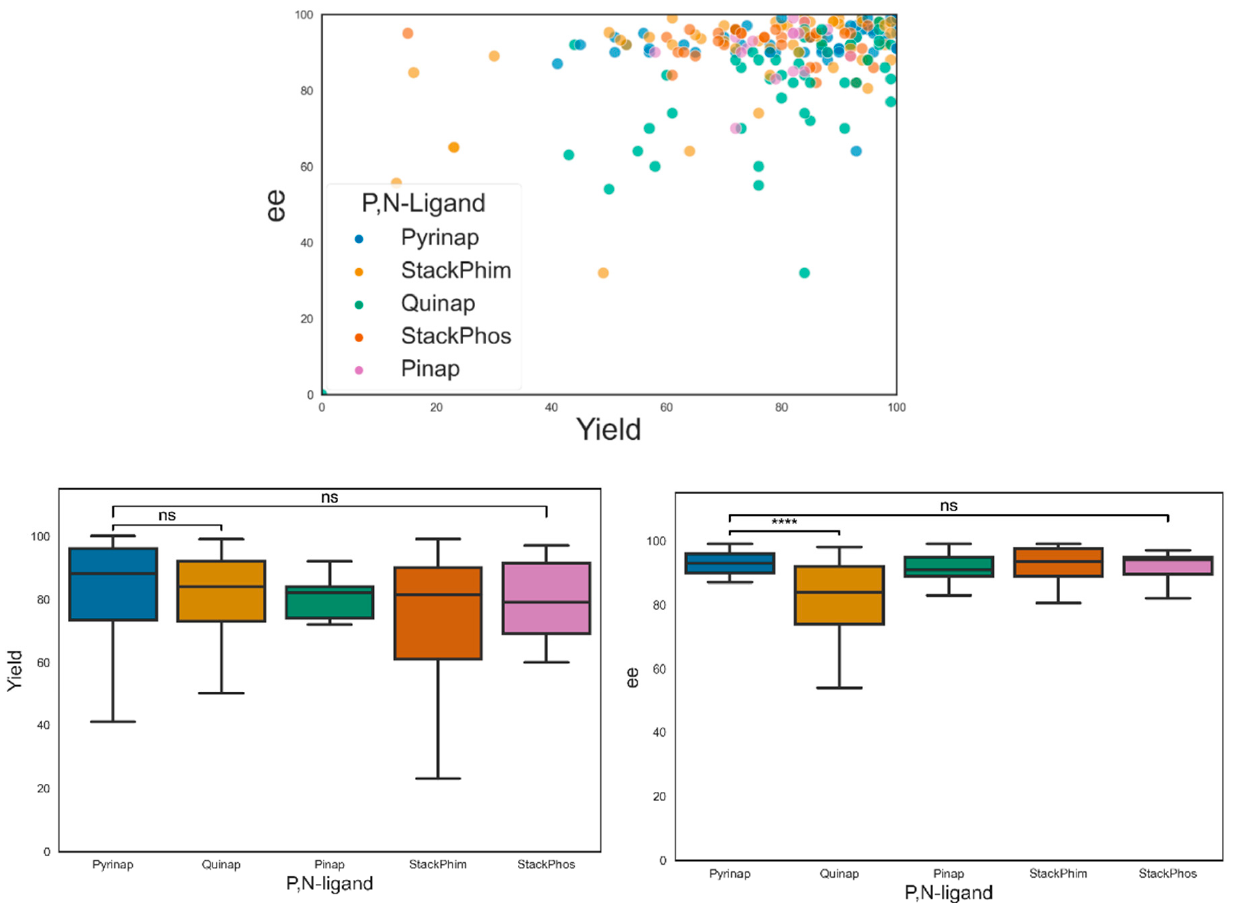
Figure 12. ee vs. yields of P,N-ligands. Statistical analysis performed using Student’s t -test ( p = 0.085, 0.27; p = 2.81 × 10 − 6 , 0.37). Symbol Meaning: ns p > 0.05, **** p ≤ 0.0001 (For the last two choices only).